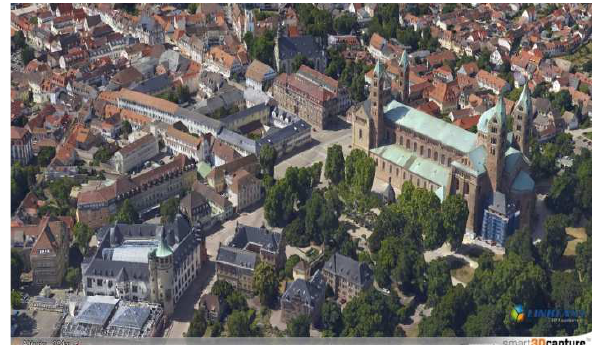
Figure 12: t he remaining errors and their directions can be seen on a selected